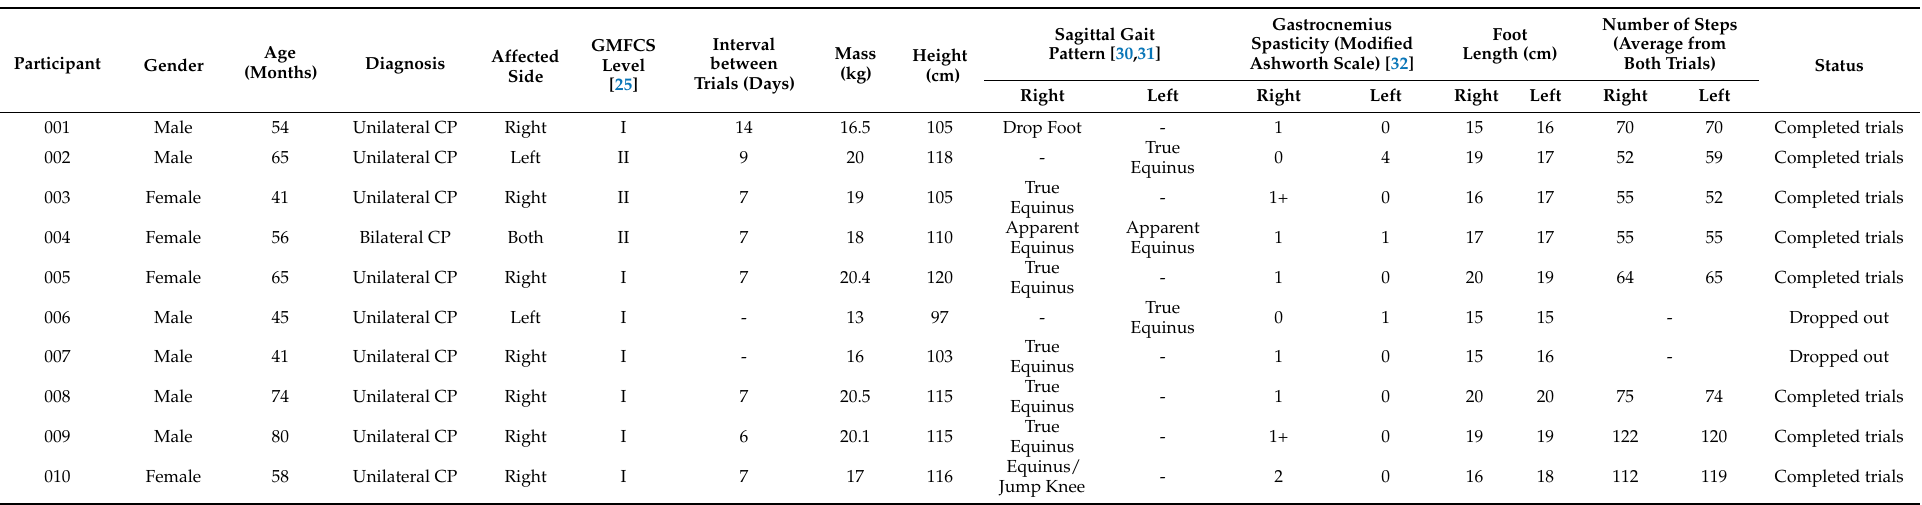
Table 1. Participants’